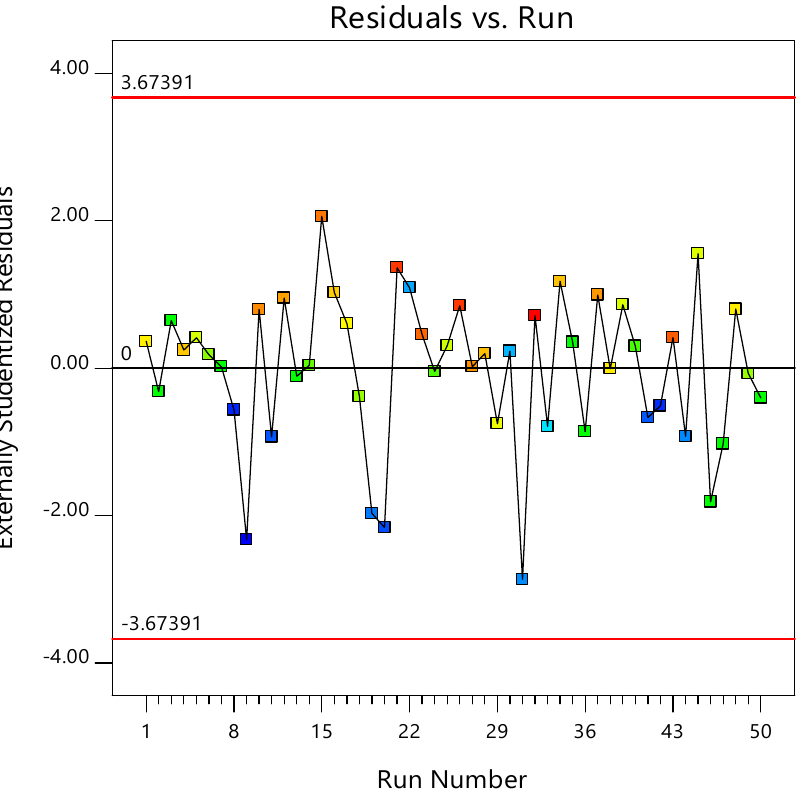
Figure 7. Probability plot of externally studentized residuals vs. Run Number for CIP removal.